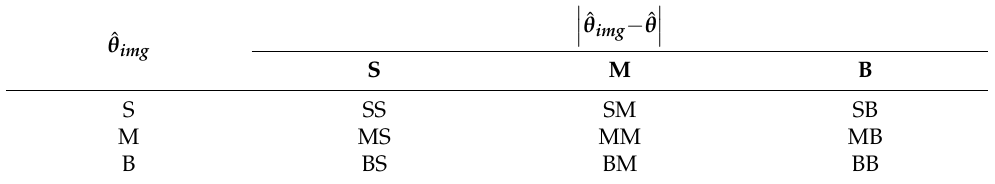
Table 2. Fuzzy rules for the road excitation threshold and the auxiliary